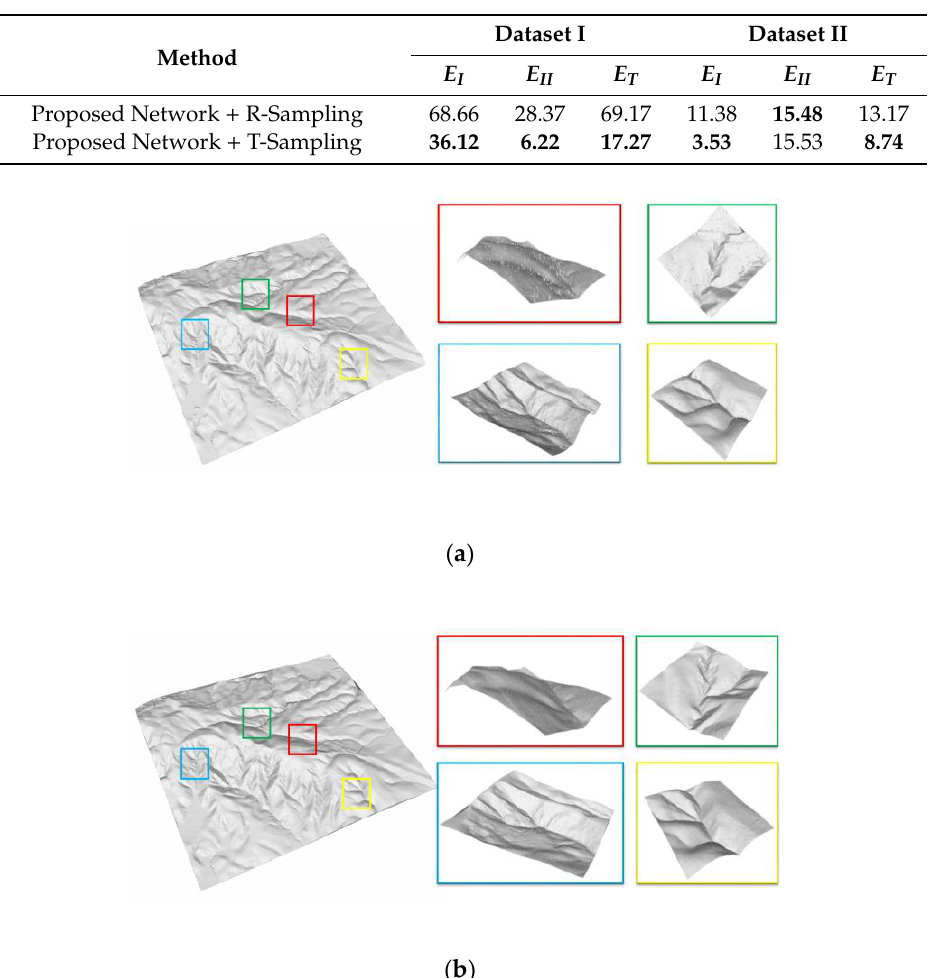
Figure 10. Filtered results of Dataset II: ( a ) R-Sampling method; ( b ) proposed T-Sampling method.